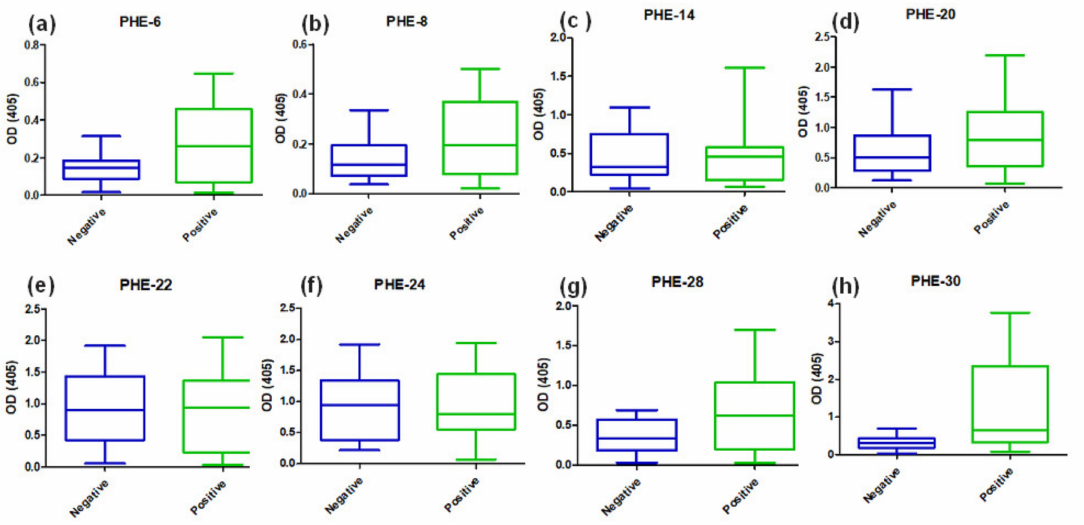
Figure 4. Serological reaction of COVID-19 positive and negative PCR diagnosed subjects for SARS-CoV-2-designed synthetic epitope-peptides. A panel of 20 human serum samples obtained from PCR positive COVID-19 diagnosed patients, and 20 human serum samples from negative diagnosed subjects, were tested for their immuno-reactivity for epitope-peptides representing the whole panel of SARS-CoV-2 target proteins S, E, M, N, 3a and 7a of this work. A di ff erential epitope molecular recognition is revealed in these multiple tests. Tested epitope-peptides were ( a ) PHE-6 from ORF2, ( b ) PHE-8 from ORF2, ( c ) PHE-14 from ORF2, ( d ) PHE-20 from ORF4, ( e ) PHE-22 from ORF5, ( f ) PHE-24 from ORF7A, ( g ) PHE-28 fromORF9 and ( h ) PHE-30 from